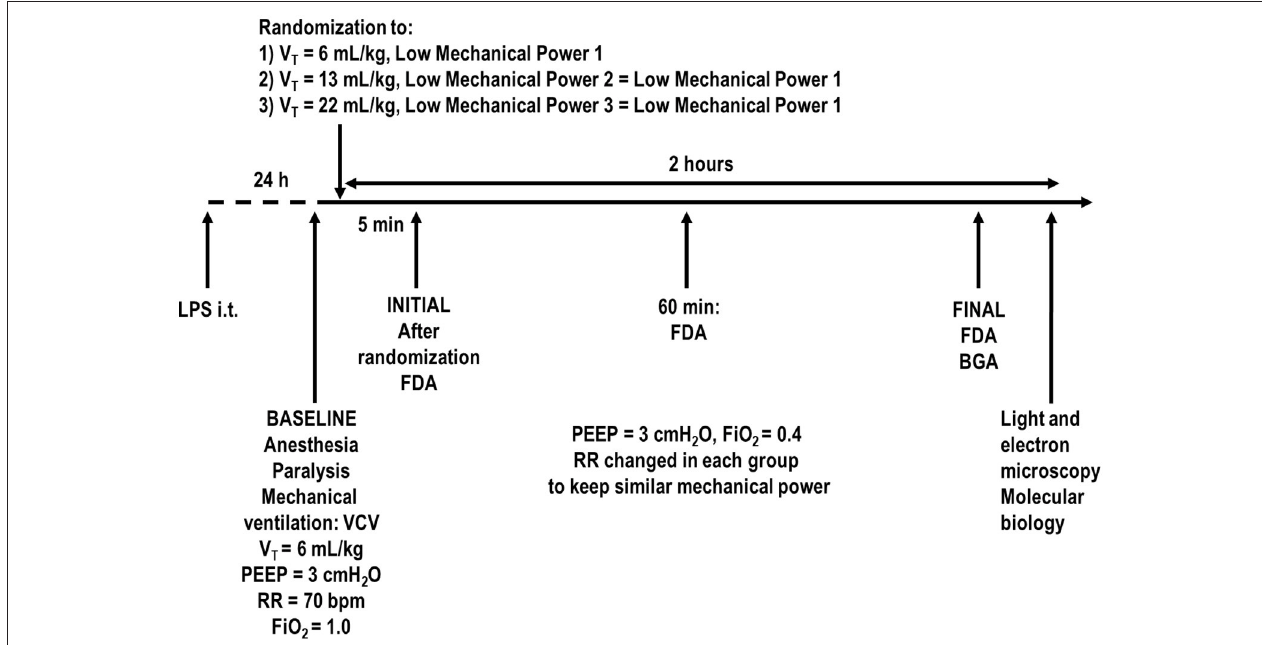
FIGURE 1 | Timeline representation of the experimental protocol. FDA, functional data acquisition; BGA, blood gas analysis; FiO 2 , fraction of inspired oxygen; LPS, Escherichia coli lipopolysaccharide; i.t., intratracheally; PEEP, positive end-expiratory pressure; PV curve, pressure-volume curve; RR, respiratory rate; VCV, volume-controlled ventilation; V T , tidal volume. Lung mechanics were assessed every 15min.